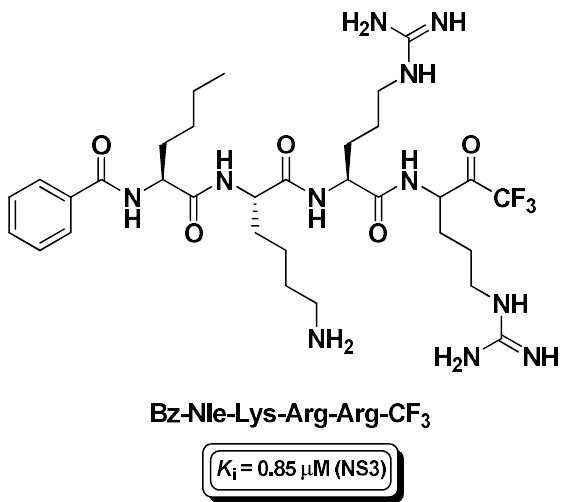
Figure 18. Structure and activity of the t-PFMK developed by Yin Z. et al. as Dengue virus NS3